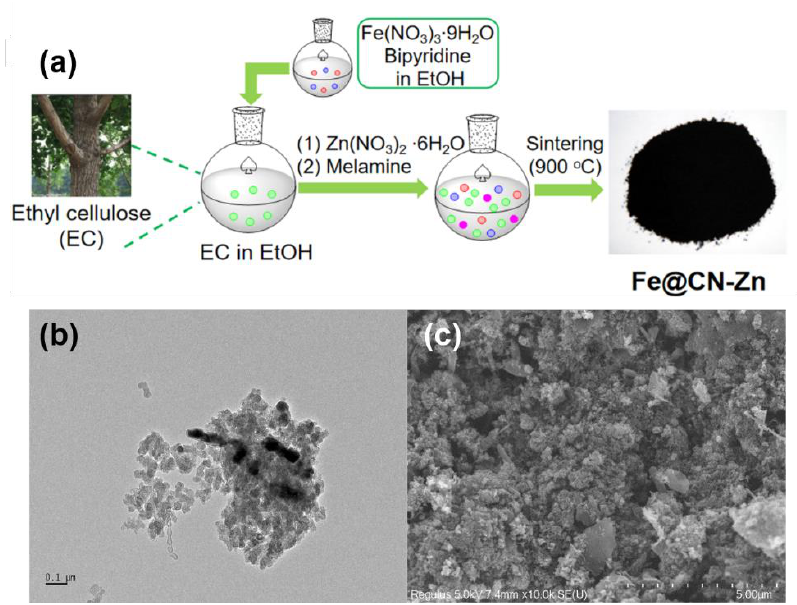
Figure 2. ( a ) Schematic illustration of the synthesis of Fe@CN-Zn. ( b ) TEM and ( c ) SEM images of Fe@CN-Zn. Reprinted with permission from Ref. [50]. Copyright 2021, Elsevier.